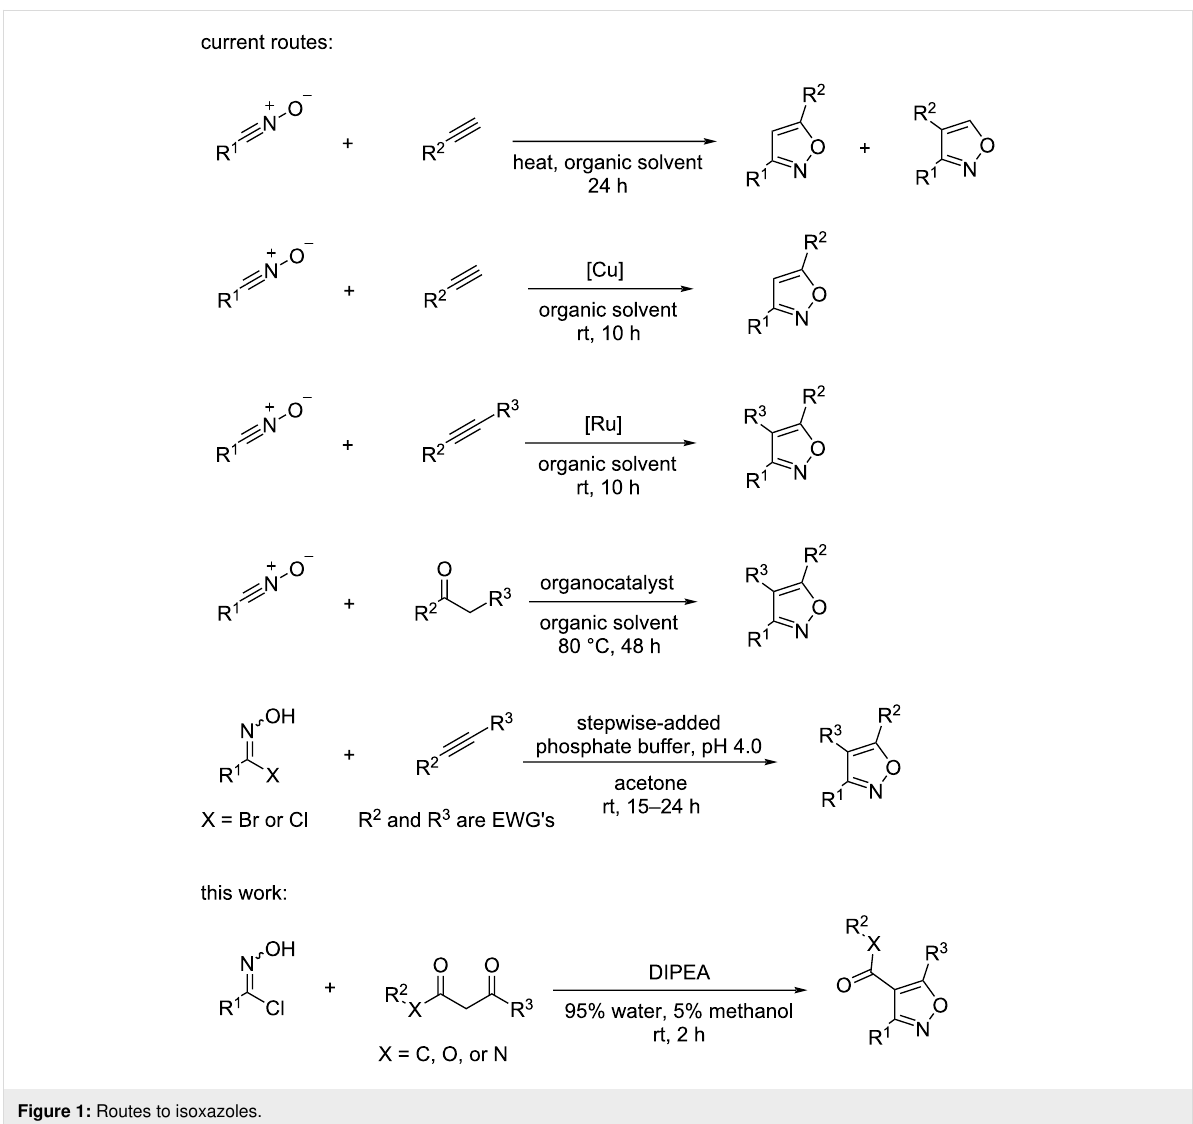
Figure 1: Routes to